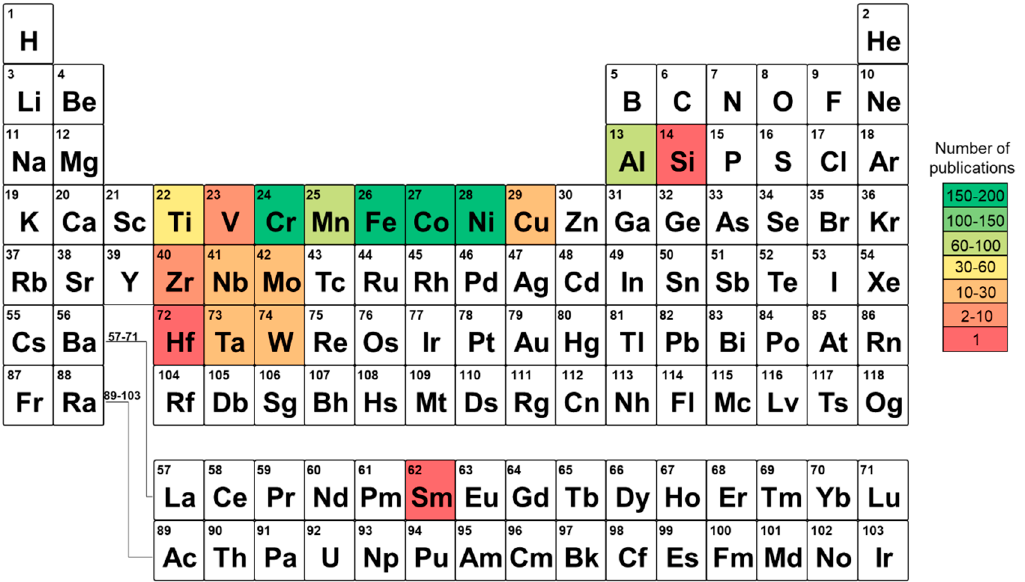
Figure 4. Common alloying elements for HEAs along with number of publications that relate to various combinations of chemical composition.